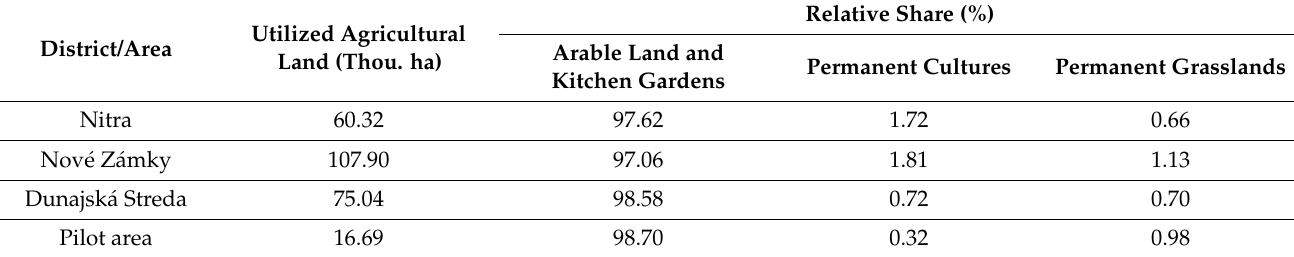
Table 2. Relative share of arable land, permanent grasslands and permanent cultures within UAL of selected districts/areas of Slovakia.